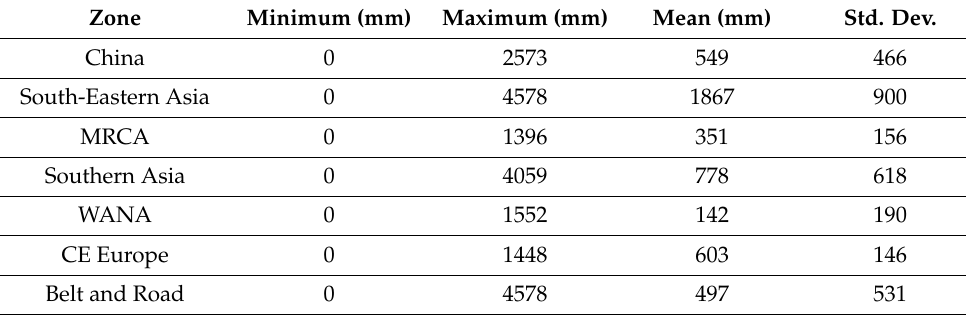
Table 2. “Belt and Road” regional precipitation statistics table.